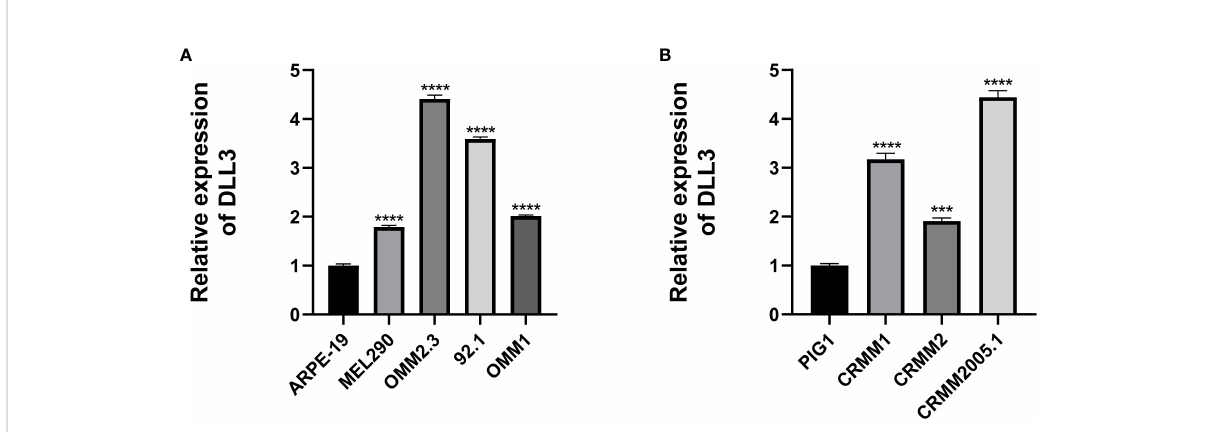
FIGURE 7 Cell lines were used to validate the aberrant expression of DLL3 in ocular melanoma. (A) The expression level of DLL3 in UM cell lines was signi fi cantly higher than that in the control cell line. (B) The expression level of DLL3 in CM cell lines was high compared to the control. *** P < 0.001, **** P <